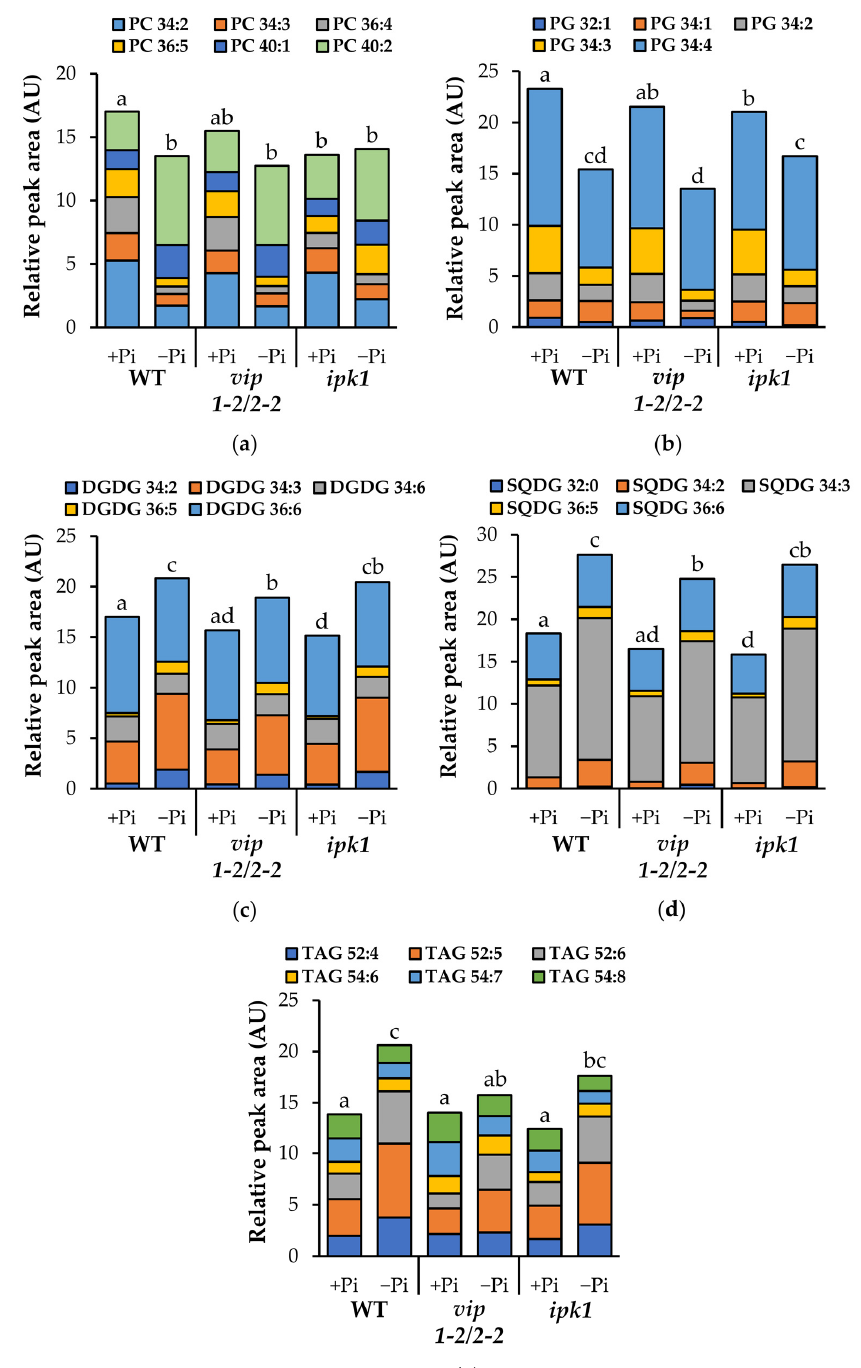
Figure 7. Composition of major phospholipid and galactolipids under Pi-replete and limiting conditions. Lipids were extracted and analyzed from wild type (WT), vip1-2 / 2-2 , and ipk1 in 18-day- old shoot tissue grown on 1 mM Pi (+Pi) and 10 µ M Pi ( − Pi) agar media. Individual lipid species are indicated by stacked bars. ( a ) Relative peak area of phosphatidylcholine (PC). ( b ) Relative peak area of phosphatidylglycerol (PG). ( c ) Relative peak area of digalactosyldiacylglycerol (DGDG). ( d ) Relative peak area of sulfoquinovosyldiacylglycerol (SQDG). ( e ) Relative peak area of triacylglycerol (TAG). Values are cube root-transformed relative peak area units and means of six biological replicate experiments assayed in technical triplicate. Letters ( a – e ) indicate statistical groups according to post hoc Tukey HSD test ( α =